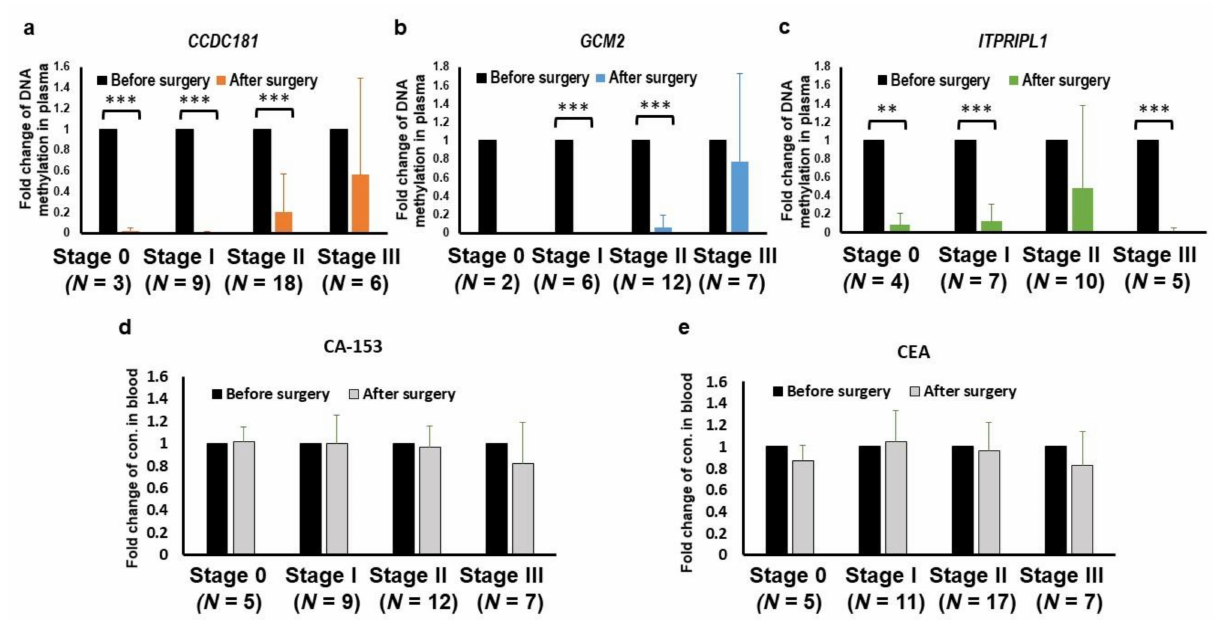
Figure 6. Changes in aberrant circulating hypermethylated CCDC181 , GCM2 and ITPRIPL1 before and after surgery at different stages. Bar charts for CCDC181 ( a ), GCM2 ( b ), ITPRIPL1 ( c ), CA-153 ( d ), and CEA ( e ) are shown; ** p ≤ 0.001; *** p ≤